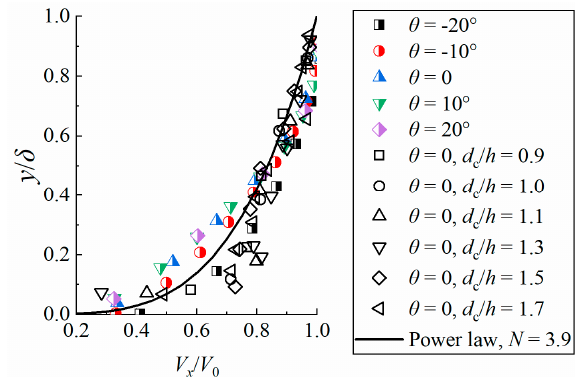
Figure 3. Velocity distributions in the boundary layer at vertices of step no. 10. A half-filled symbol refers to numerical results (this study), and an open one to experimental ones [23].